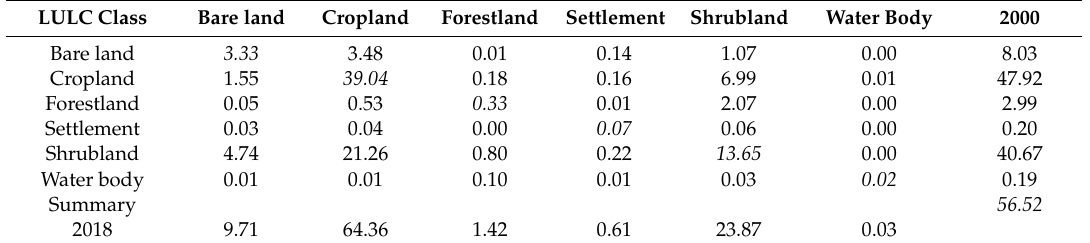
Table 5. Change matrix showing the LULC classes changes between 2000 and 2018 in percentage (%).